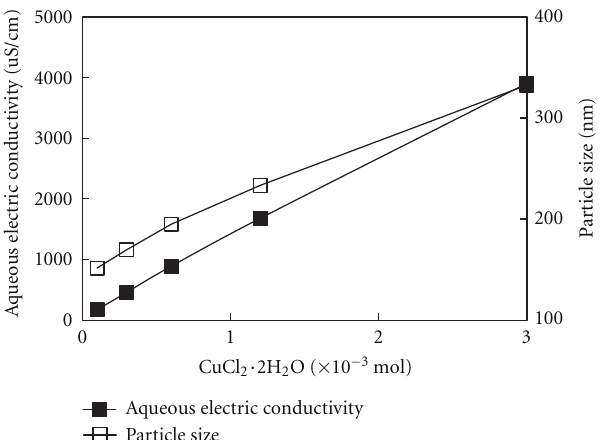
Figure 4: Aqueous electrical conductivity and average copper particle size at di ff erent copper ion concentrations.